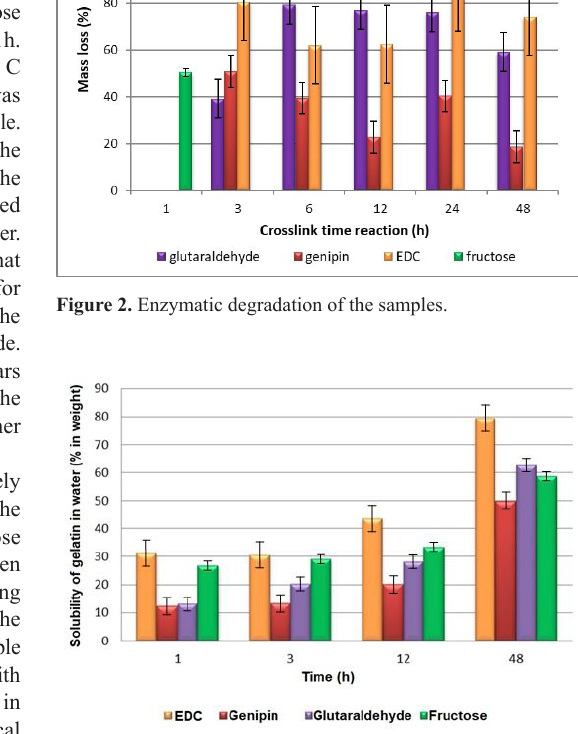
Figure 3. Water solubility of the